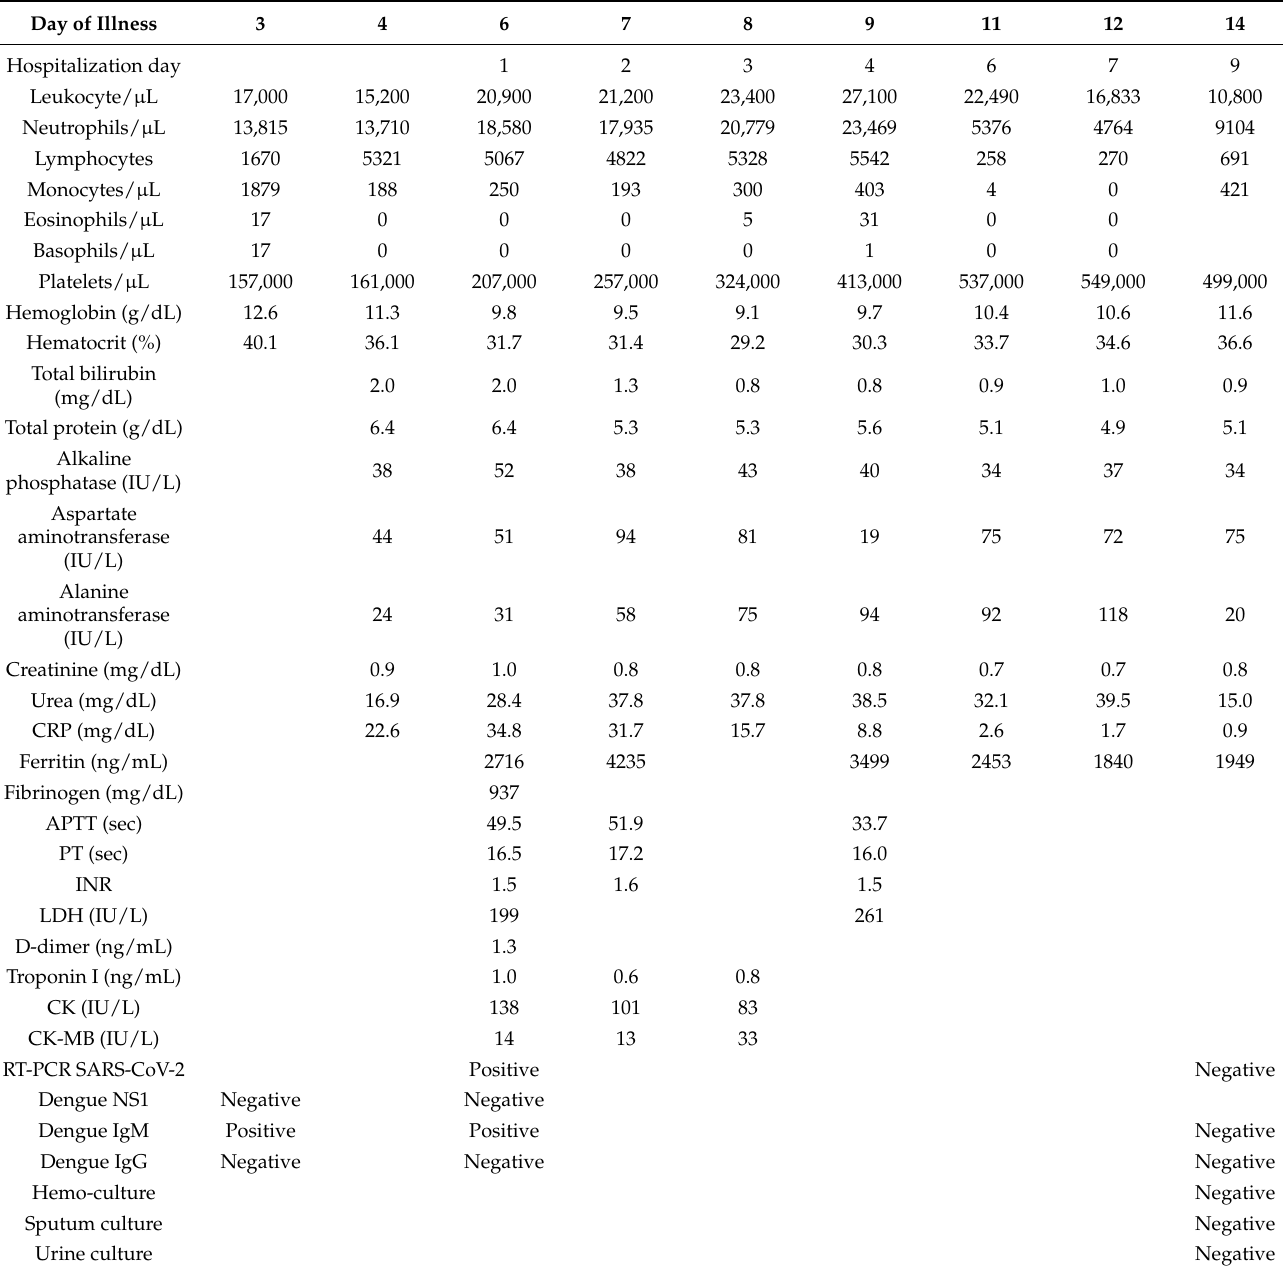
Table 1. Serial hematological, biochemical profile and inflammatory